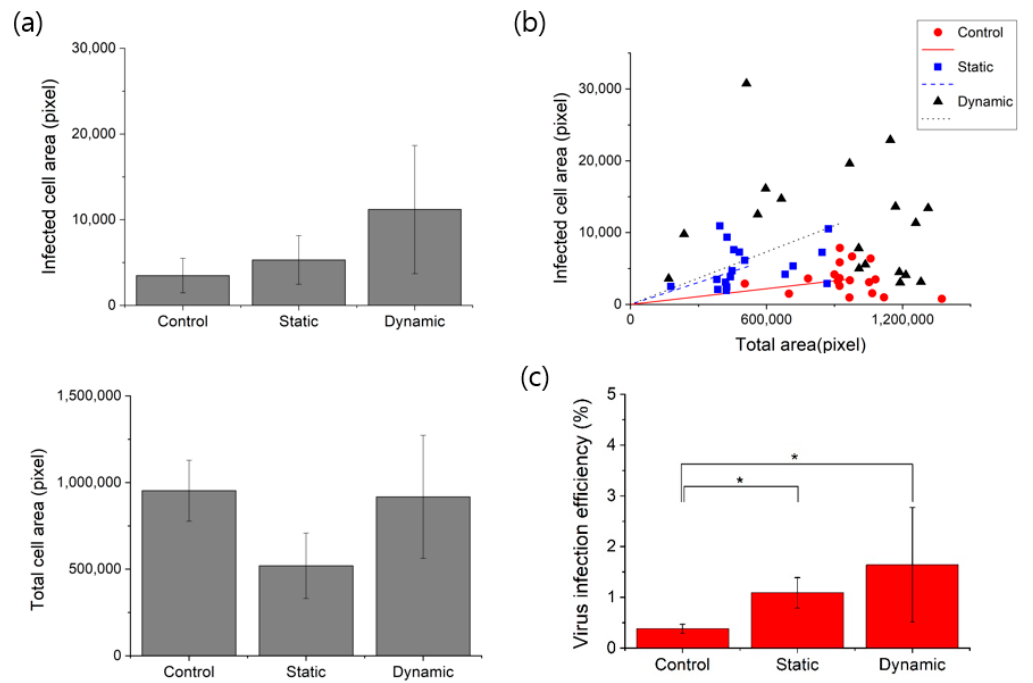
Figure 7. Virus infection in the conventional culture, static microchannel culture and dynamic cell culture system. ( a ) Comparison of virus-infected cell (EGFP) area and total cell area. ( b ) Comparison of virus infection efficiency (infected cell area against total cell area). ( c ) Efficiency of virus infection on NIH/3T3 cells. t -tests, * p < 0.01.